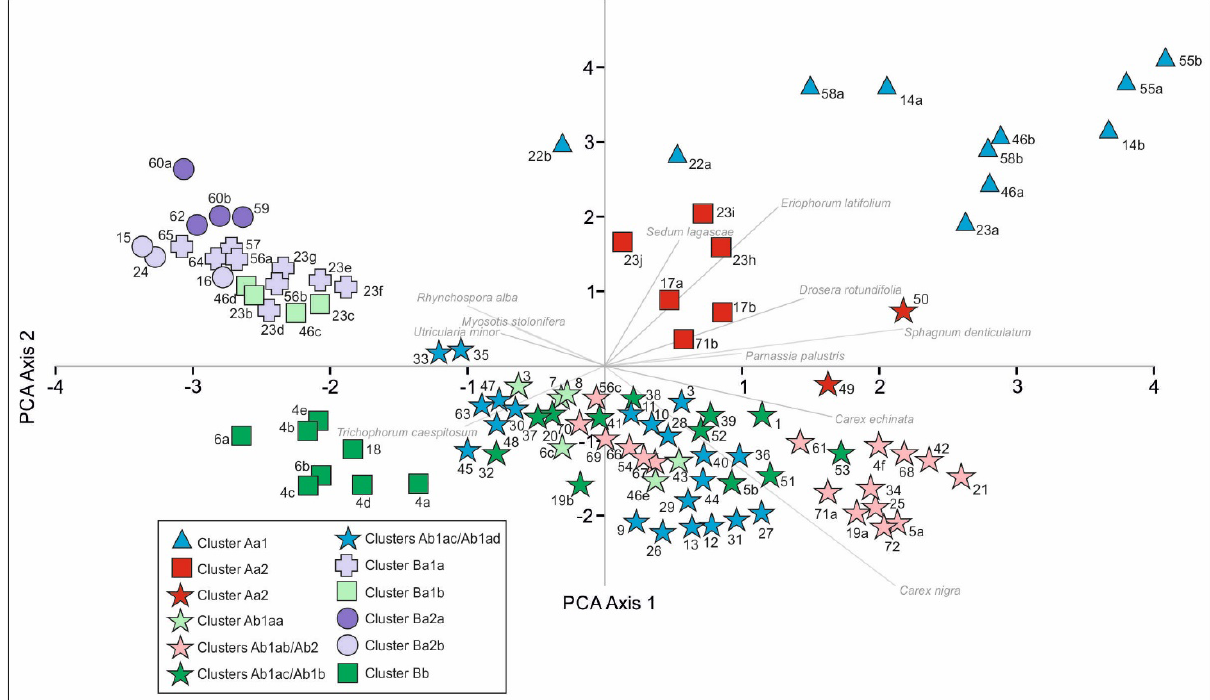
Figure 5. Ordination results of principal component analysis (PCA) for major plant taxa and 103 relevés. The first two axes explain 59.9% of the variance in the dataset (Axis 1 = 32.6%, Axis 2 =